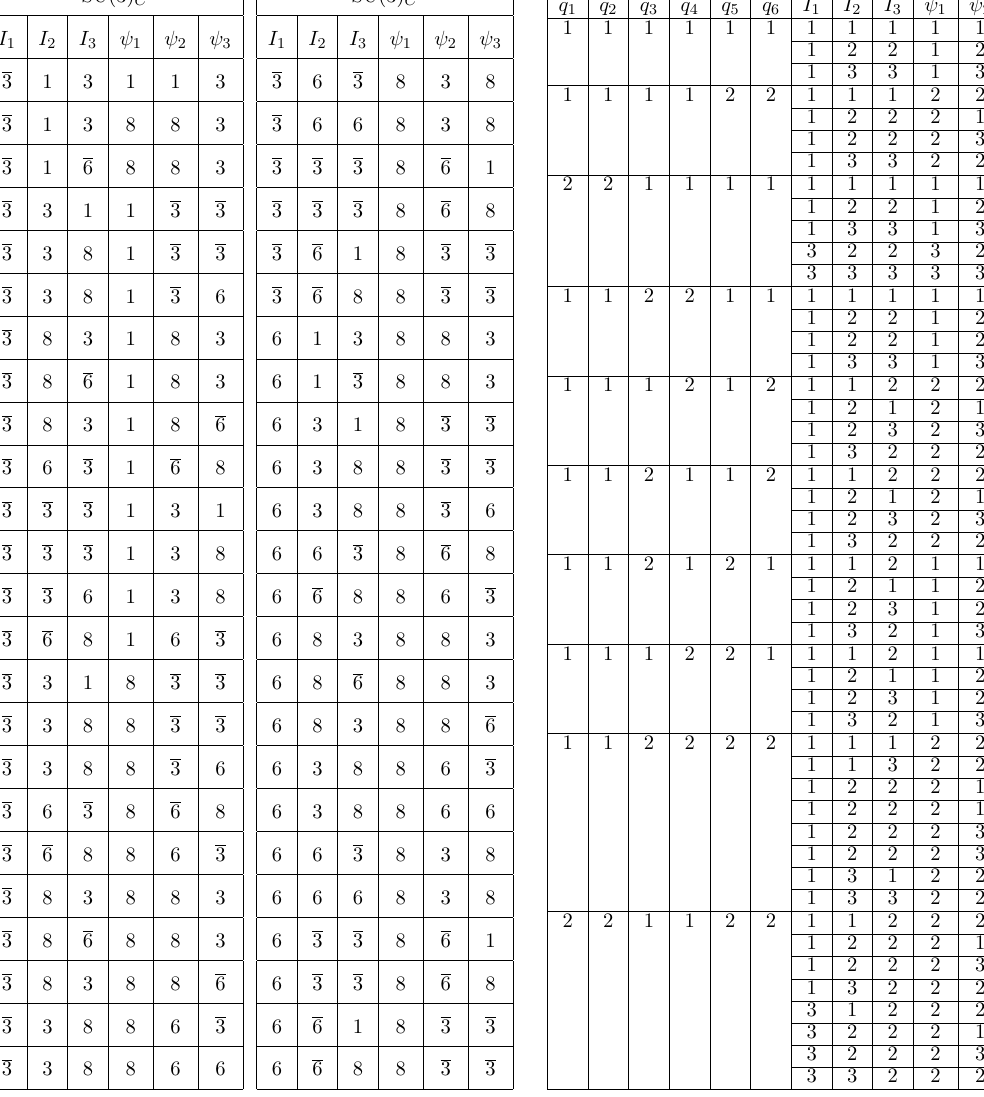
Table 7 . The possible SU(3) C and SU(2) L numbers of the fields in